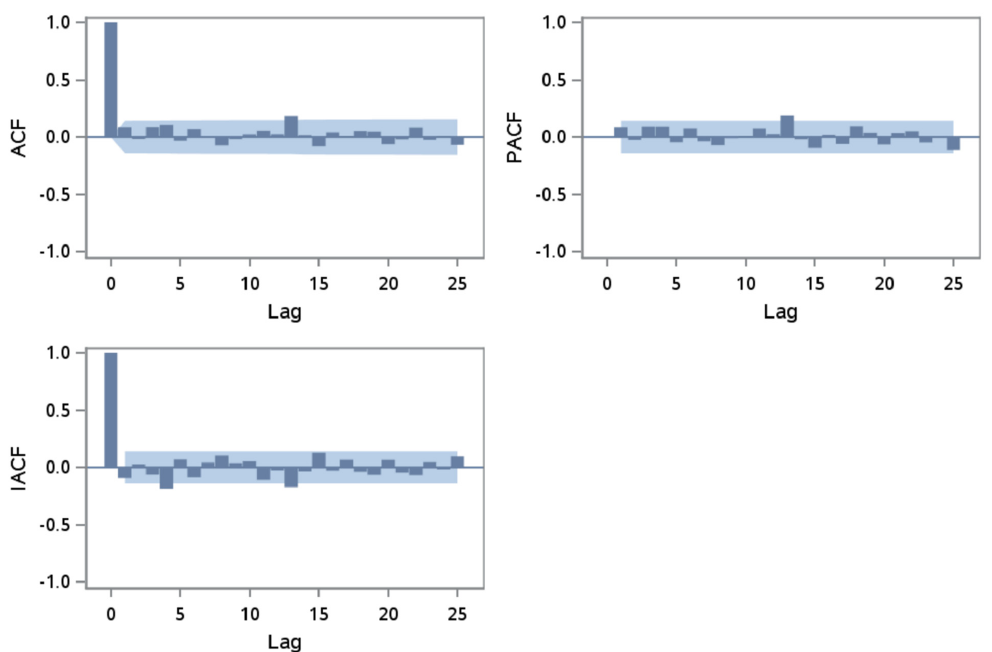
Figure 5. Autocorrelation, inverse autocorrelation, and partial autocorrelation function of the residuals produced by the autoregressive function.